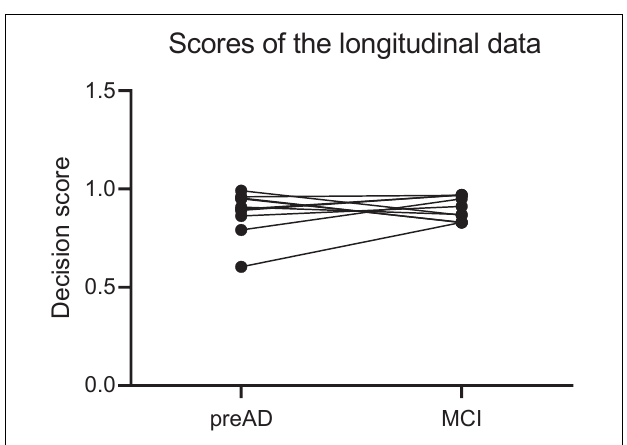
FIGURE 6 | The scores of the longitudinal data in preAD stage and MCI stage.